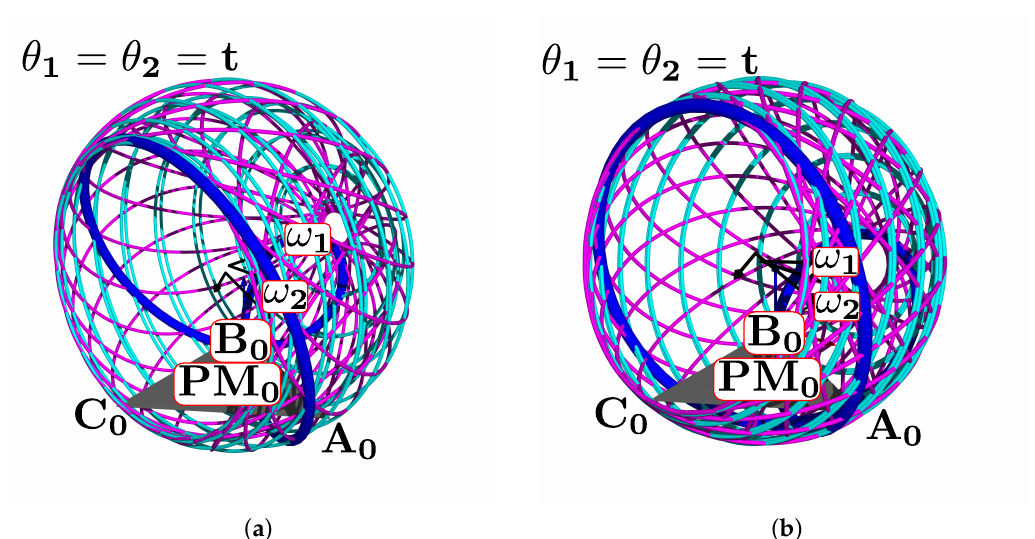
Figure 27. Attaching point B simulation: ( a ) adding 10% to the statistic mean values, ( b ) subtracting 10%.